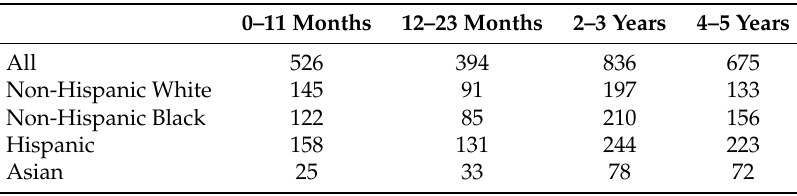
Table 1. Sample sizes by age and race/ethnicity, NHANES